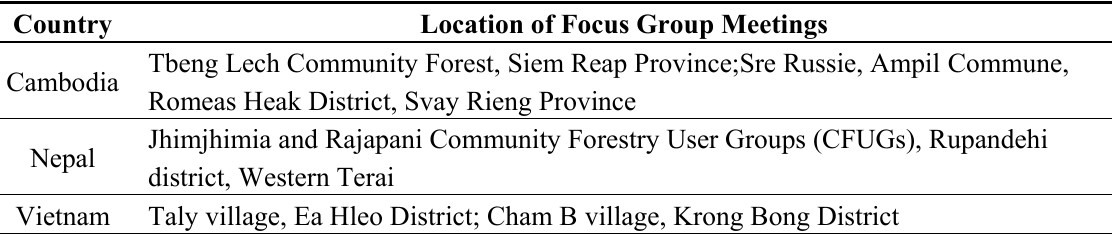
Table 1. Location of the focus group meetings in Cambodia, Nepal and